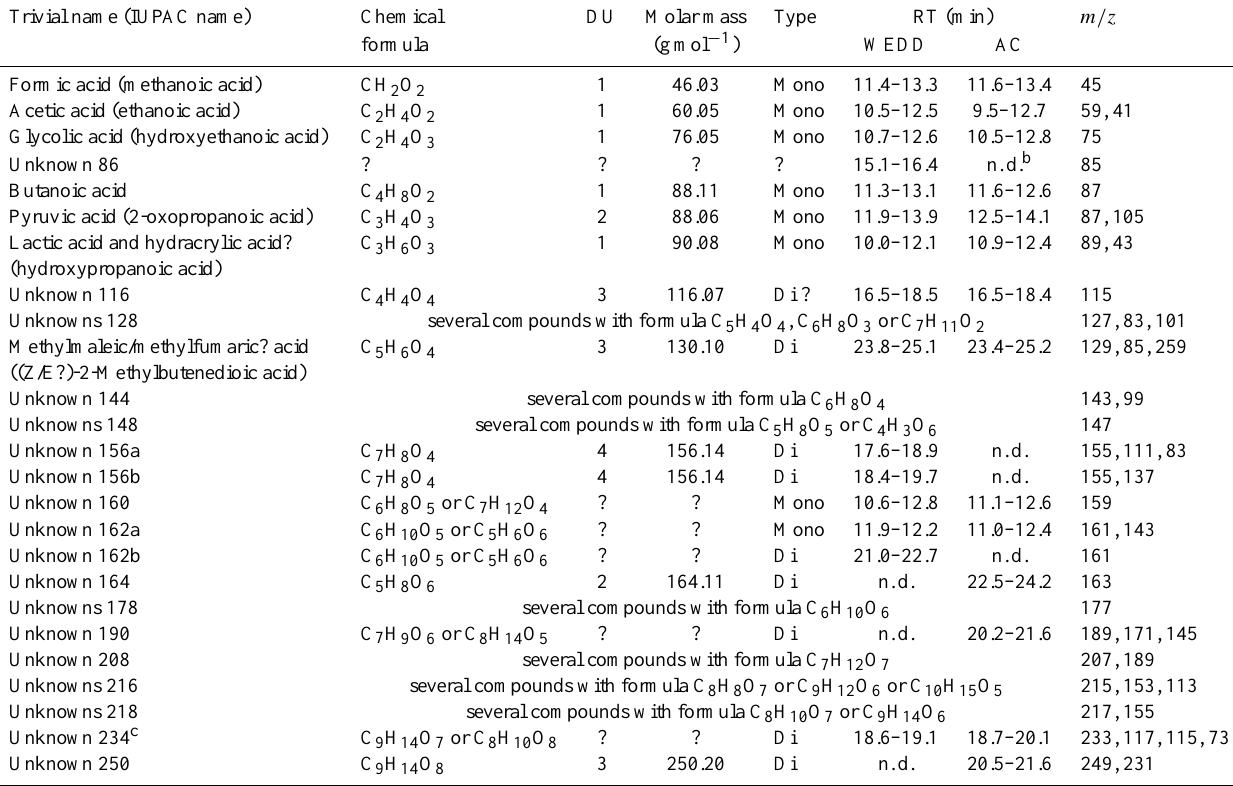
Table 2. Organic acids detected with WEDD/AC-IC/MS during 1,3,5-trimethylbenzene (TMB) photooxidation.